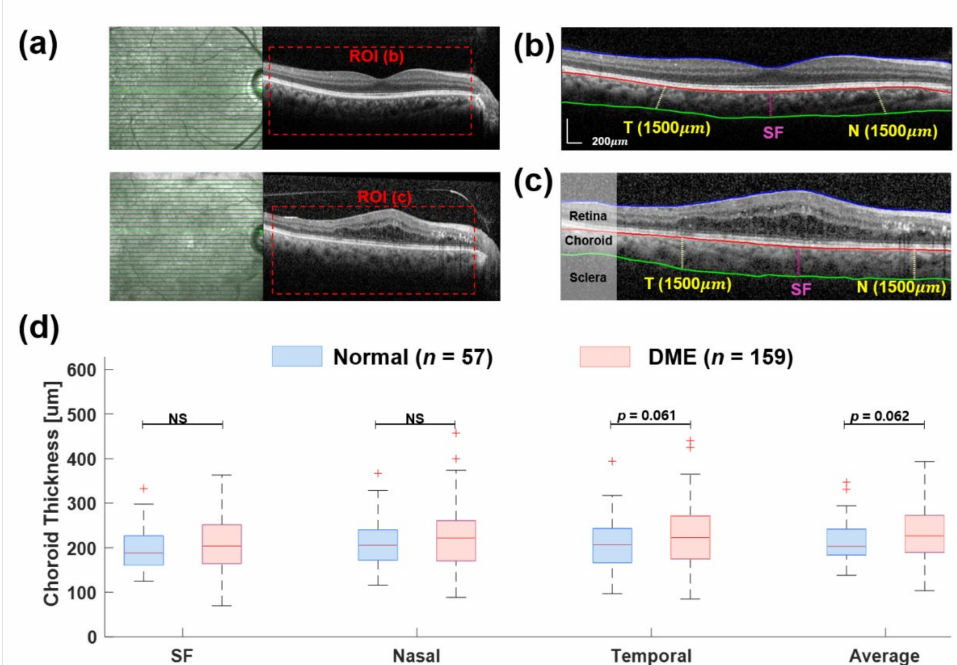
Figure 4. Comparing choroid thickness between normal and diabetic patients based on image automated retinal and choroidal thickness segmentation. ( a ) OCT image scans of two subjects with normal and diabetic macular edema (DME) eyes. Images processing perfumed at ROI ( b , c ). Example segmentation image of the normal eye ( b ) and DME ( c ) represent the retinal and choroid boundary layers. The solid lines correspond to the extracted boundary positions on the outer retinal surface (blue), BM (red), and choroid scleral junction (green). The vertical lines indicate the thickness of the choroid at 500 µ m intervals from nasal (N) to temporal (T) to the subfoveal (SF). ( d ) Comparison of choroid thickness between control ( n = 57) and DME eyes ( n = 159) obtained at different three locations (SF, N, and T) and average choroid thickness of the whole area of ROI. Comparison data are shown in composite box plots. The p -value ( p ) is used in the independent t -test. (NS: not significant; statistically significant differences: p <